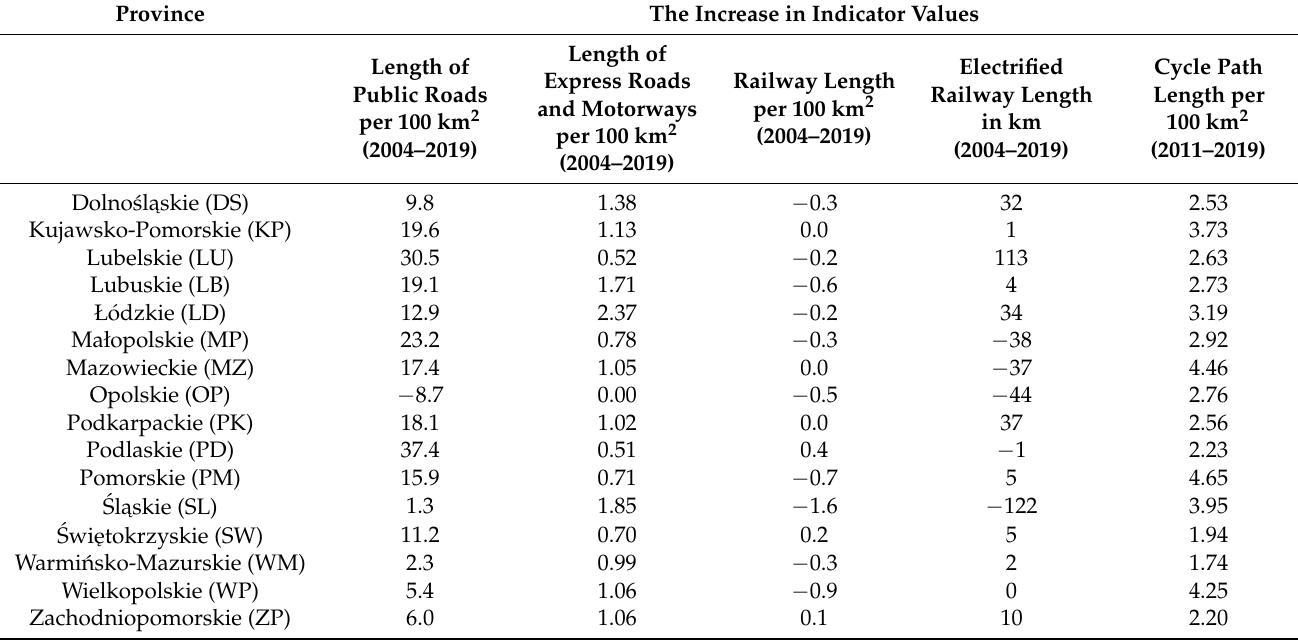
Table 1. Characteristics of transport development. Source: the authors based on [56].